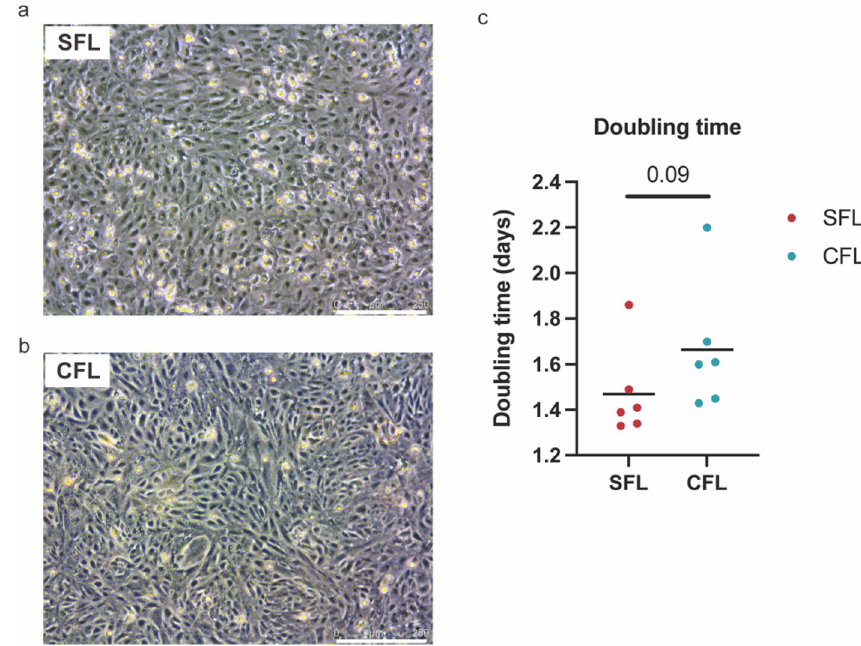
Figure 1. Brightfield images of SFL ( a ) and CFL ( b ). The scale denotes 250 μM. ( c ) Graph showing the calculated doubling time for the two cell lines. p-value was calculated using two-tailed Student’s t